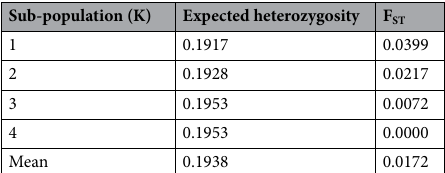
Table 8. Expected heterozygosity and FST values in four squash subpopulations.